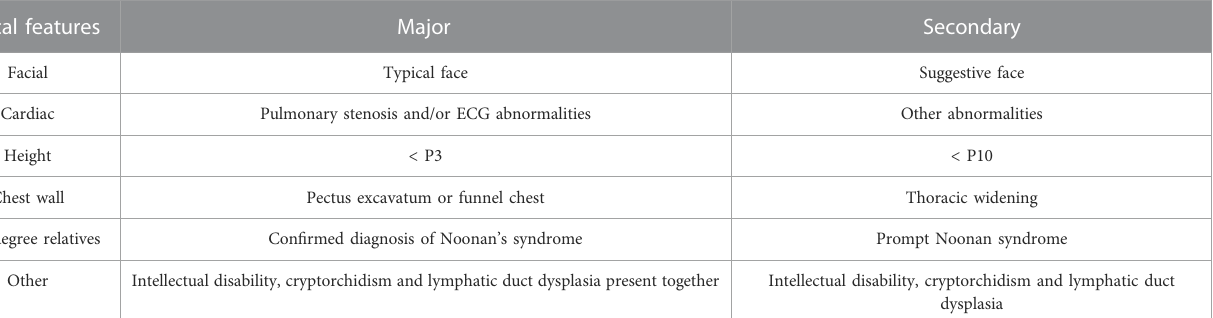
TABLE 3 Diagnostic criteria for Noonan